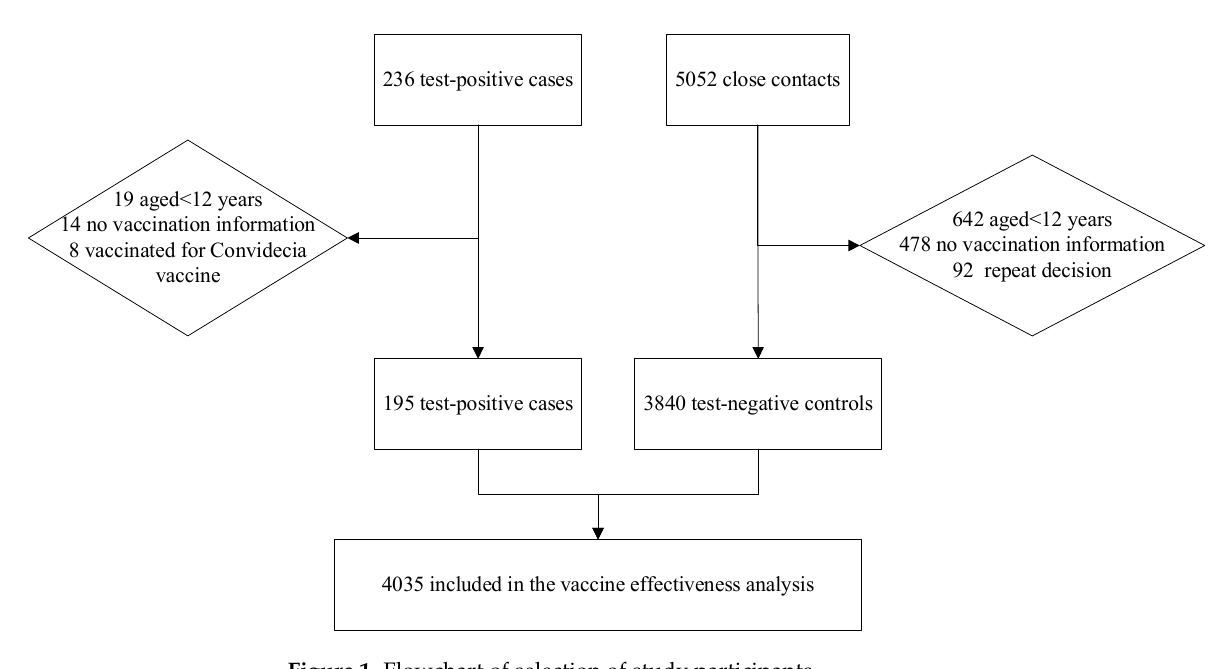
Figure 1. Flowchart of selection of study participants.